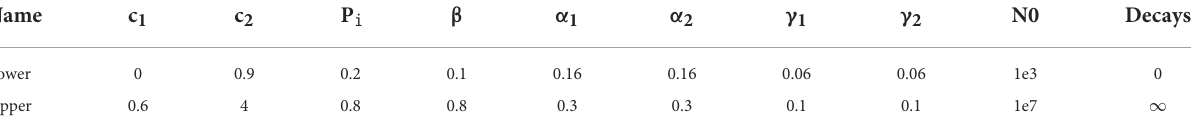
TABLE 2 Upper and lower limit interval settings for model